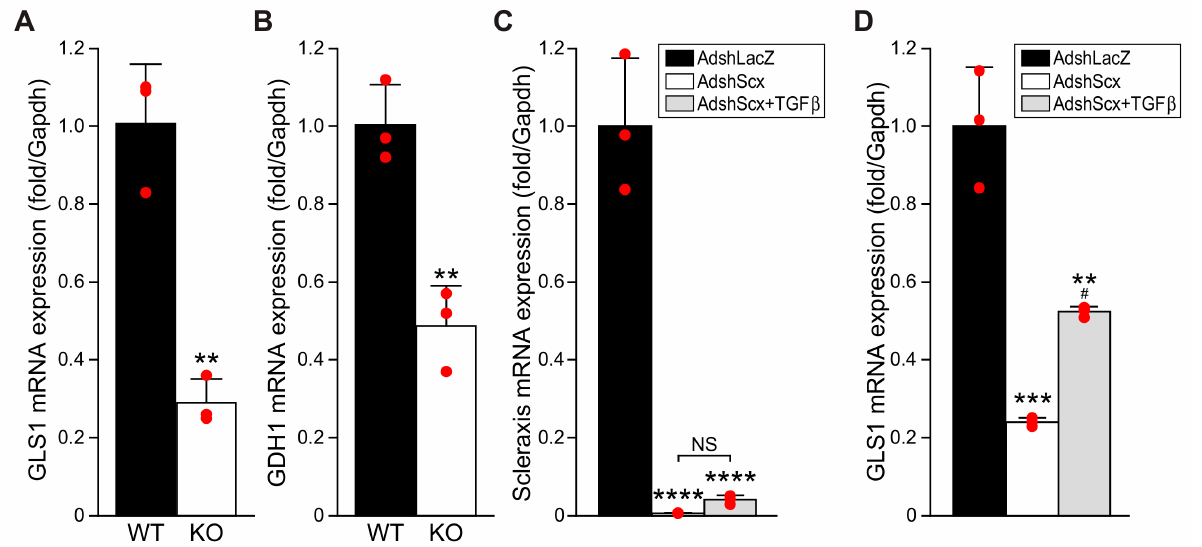
Figure 3. Loss of scleraxis attenuates glutaminolysis gene expression. ( A , B ) Cardiac fibroblasts were isolated from wild-type (WT) or scleraxis knockout (KO) mice and assayed for the expression of GLS1 ( A ) and GDH1 ( B ) by qPCR. ( C , D ) P1 rat cardiac fibroblasts were transfected with adenovirus encoding small hairpin RNA targeting LacZ (AdshLacZ) or scleraxis (AdshScx) for 72 h, with or without 10 ng/mL TGF β 1 addition after 48 h, and assayed by qPCR for expression of scleraxis ( C ) and GLS1 ( D ). Statistical analysis was by the two-tailed Student’s t-test ( A , B ) or by one-way ANOVA with the Tukey post hoc test ( C , D ) (n = 3). ** p < 0.01, *** p < 0.001, **** p < 0.0001 versus WT,